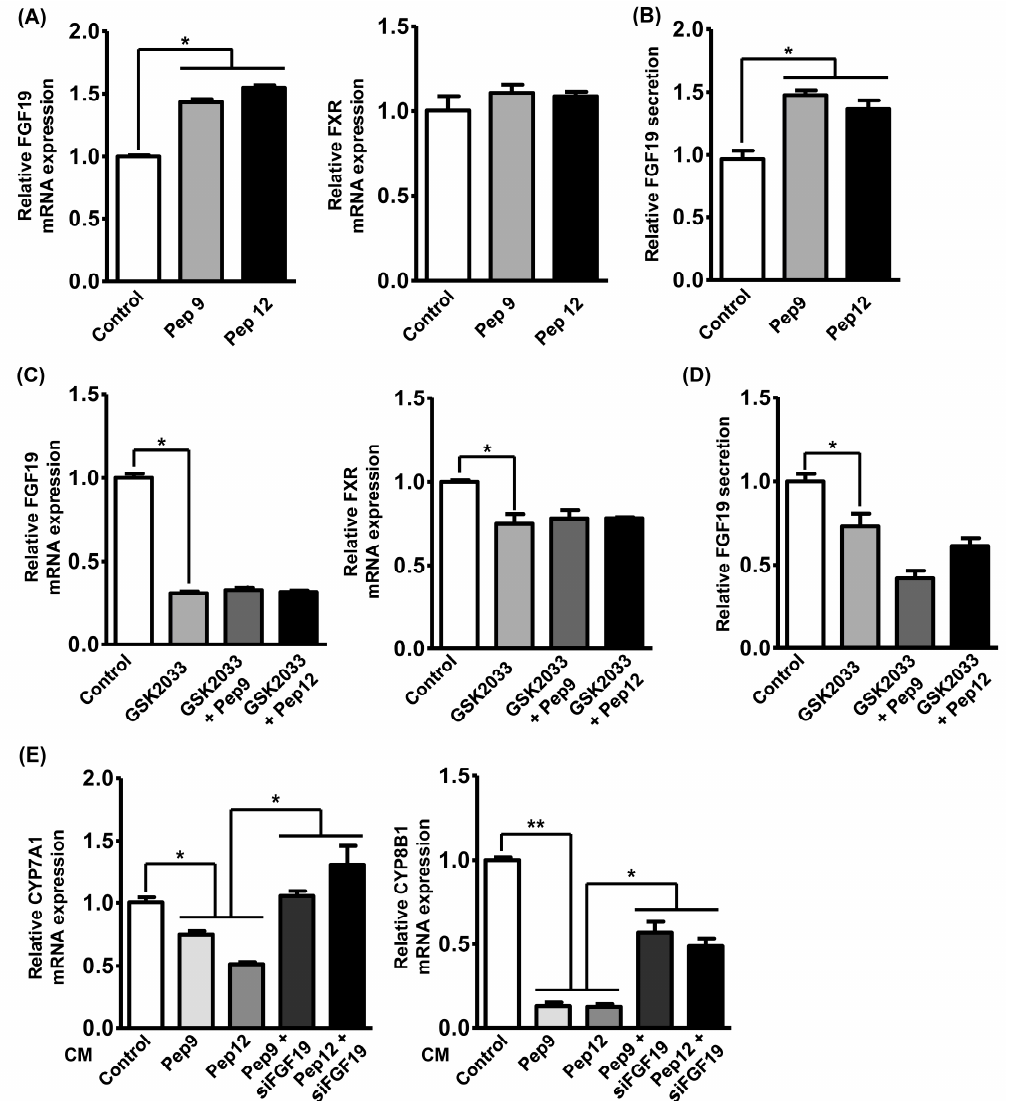
Figure 4. Enterocyte-derived FGF19 alters bile acid synthesis in the liver. ( A ) The alteration of mRNA expression of FGF19 and FXR was assessed by qRT-PCR in Caco-2 cells following treatment with peptide 9 or 12. ( B ) The alteration of secretory FGF19 level in conditioned media (CM) of Caco-2 cells was assessed by ELISA following treatment with peptide 9 or 12. ( C ) The alteration of mRNA expression of FGF19 and FXR was assessed by qRT-PCR in Caco-2 cells following treatment of GSK2033 and peptide 9 or 12. ( D ) The alteration of secretory FGF19 level in CM of Caco-2 cells was assessed by ELISA following treatment with GSK2033 and peptide 9 or 12. ( E ) The alteration of mRNA expression of CYP7A1 and CYP8B1 was assessed by qRT-PCR in MIHA cells following treatment with 4x concentrated CM from Caco-2 cells treated with peptide 9 or 12 and siRNA against mRNA of FGF19. * p < 0.05, ** p < 0.01.